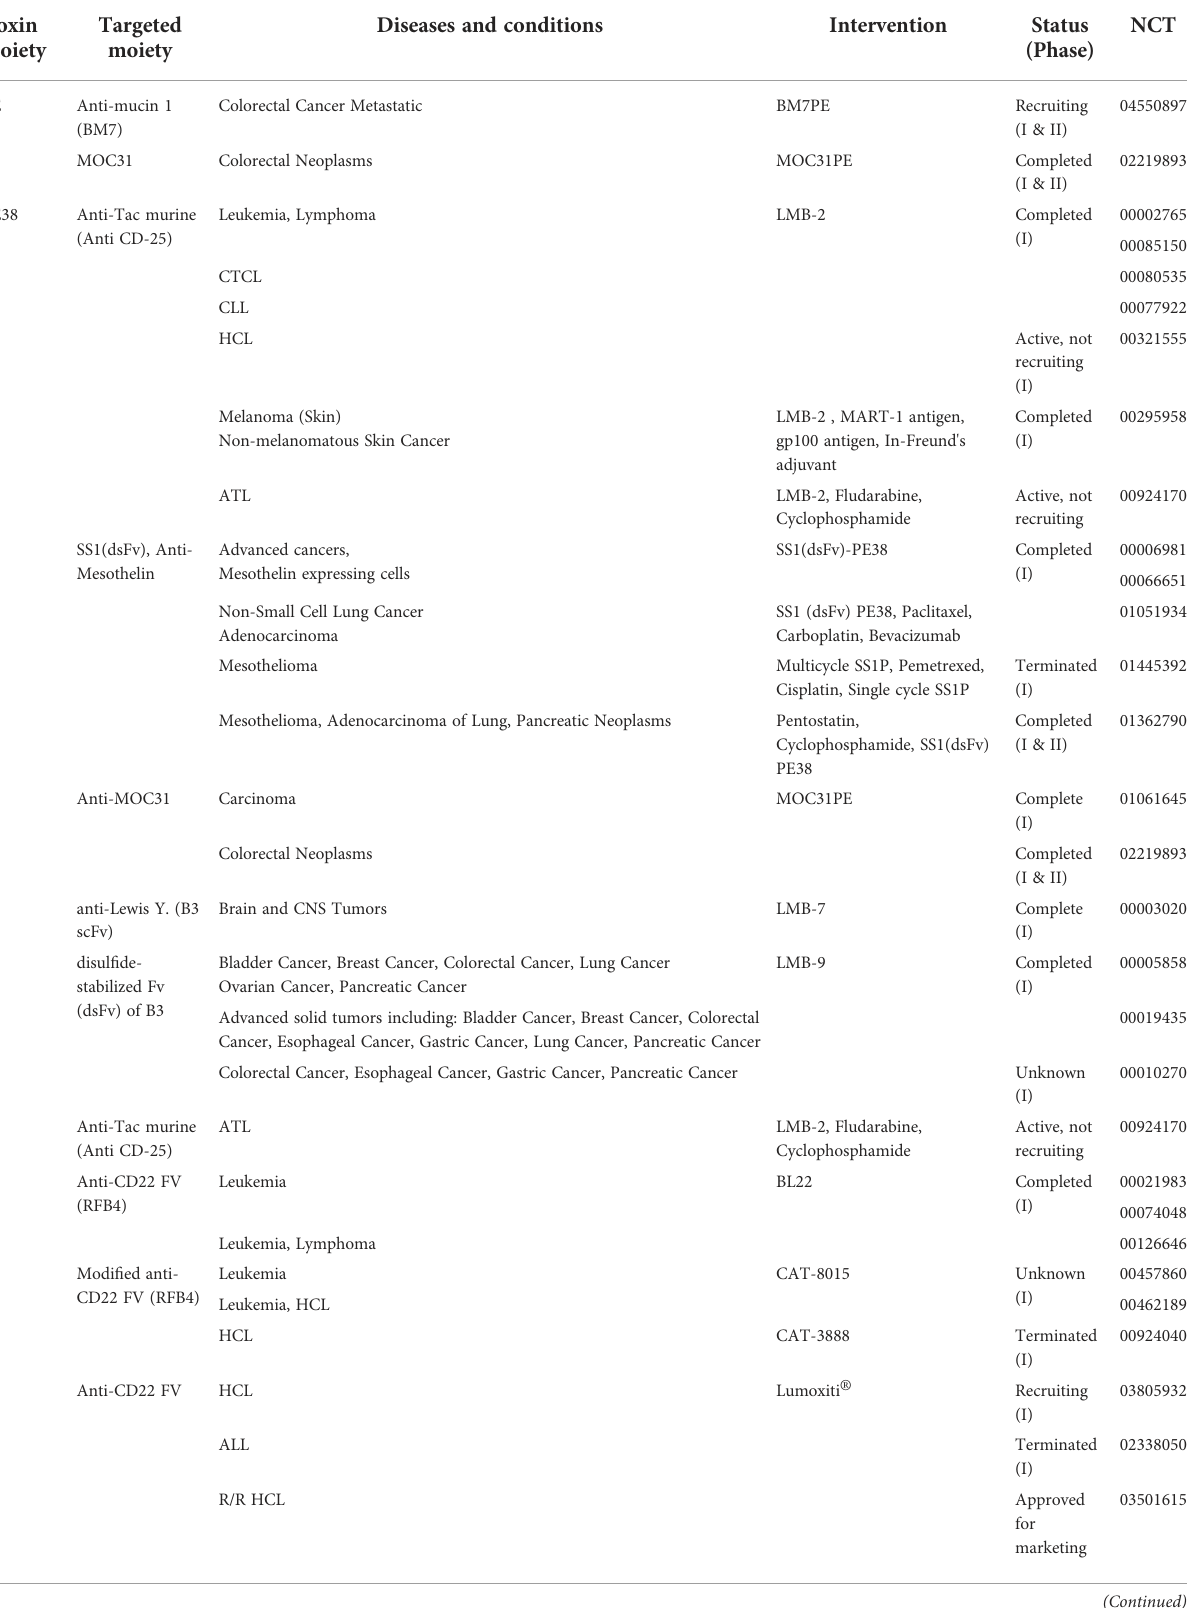
TABLE 2 The list of clinical trials of immunotoxin therapy in